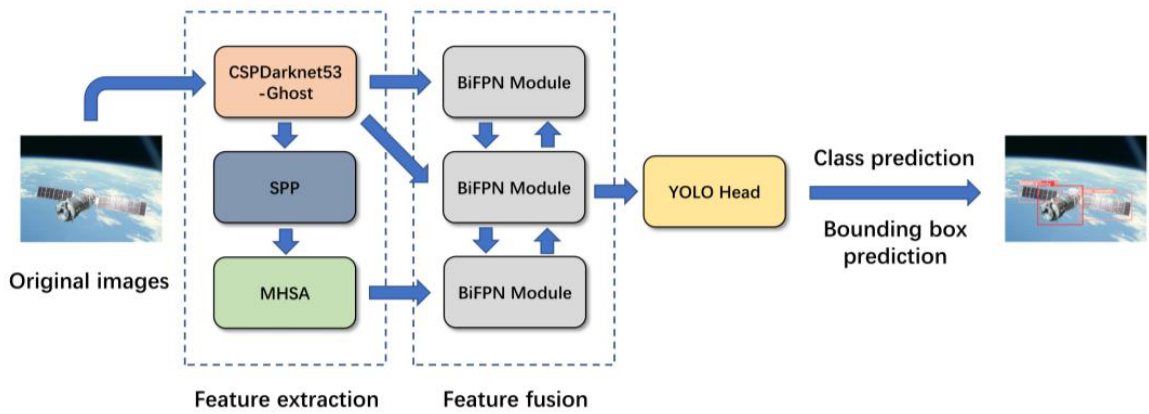
Figure 2. Several samples in the built spacecraft dataset.